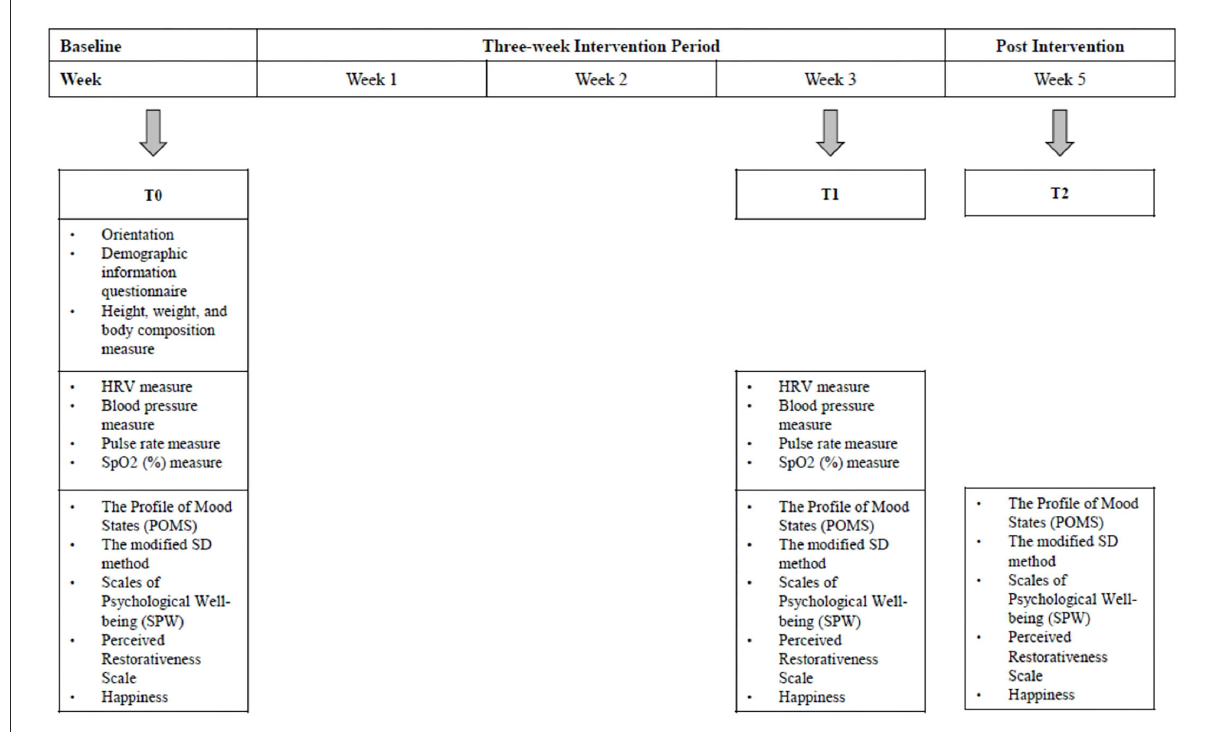
FIGURE1 Measurements at different time